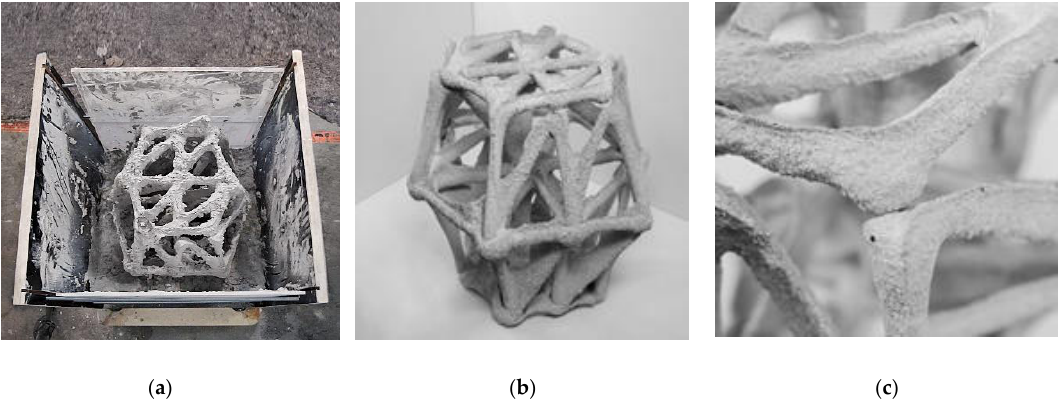
Figure 10. CiS demonstrator: ( a ) stripping the object from the formwork; ( b ) final object; ( c ) detailed view of a knot with a deficient connection.